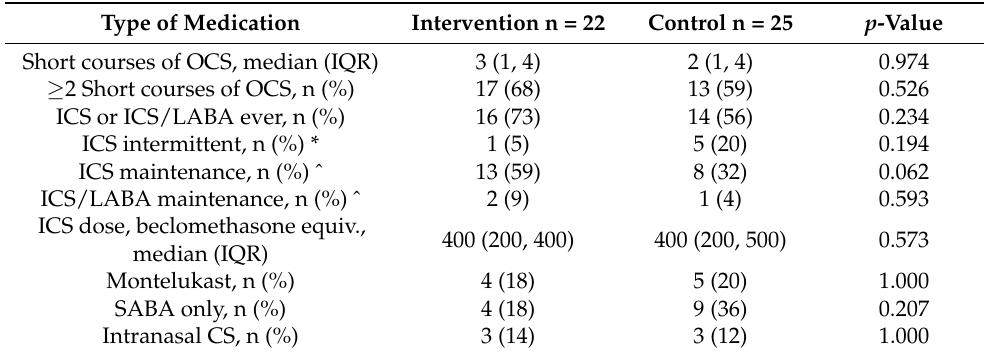
Table 2. Medication at baseline and in the previous 12